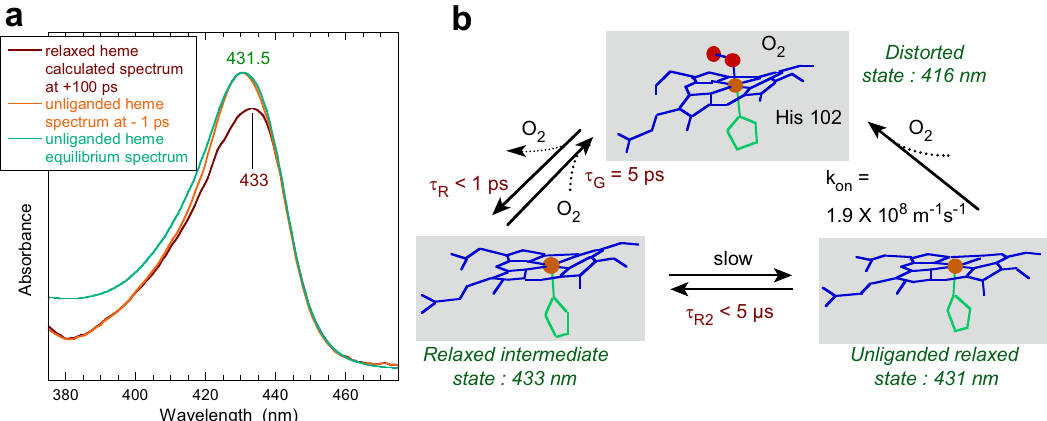
Fig. 6 Spectroscopic fi ngerprint and model. a Calculated spectrum of the relaxed 5-c ferrous heme of Ct H-NOX at + 100 ps after O 2 dissociation (red) compared with the spectrum of the unliganded 5-c heme before excitation ( − 1 ps, orange) and with the steady-state spectrum of the same sample (green). In the latter spectrum the increased absorbance below ~400 nm is due to the reductant dithionite which is less consumed. b Allosteric equilibrium based on heme distortion in the Ct H-NOX